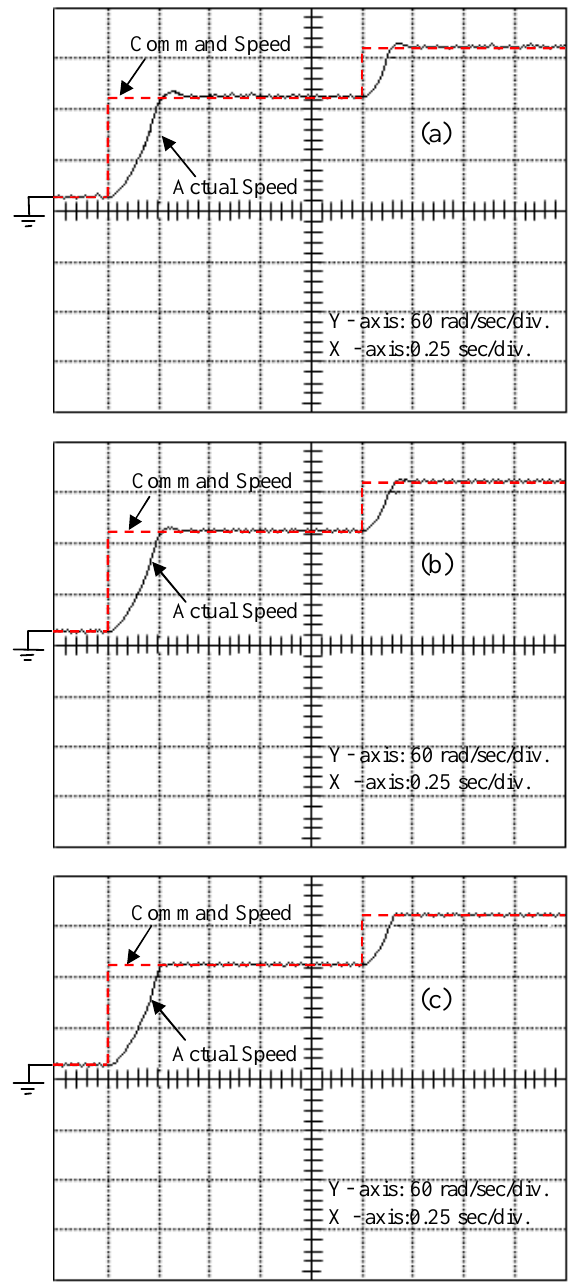
Fig. 15. Experimental results for step change in set speed for (a) PI controller (b) Fuzzy PI controller and (c) the proposed Wavelet – fuzzy controller